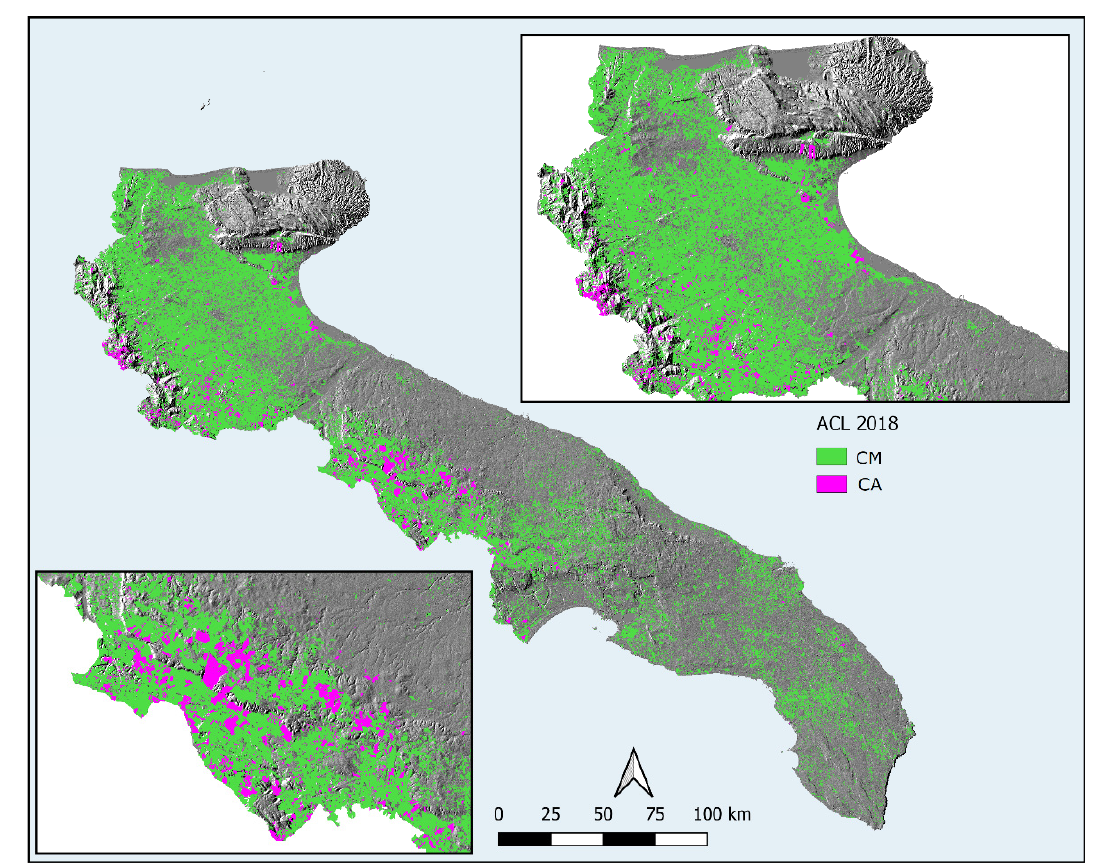
Figure 3. Annual cropland of the Apulia region in 2018 under conventional management (CM) and conservation agriculture (CA). Hill shade calculated using NASA DEM 30 m (https://lpdaac.usgs. gov/products/nasadem_hgtv001, accessed on 1 November